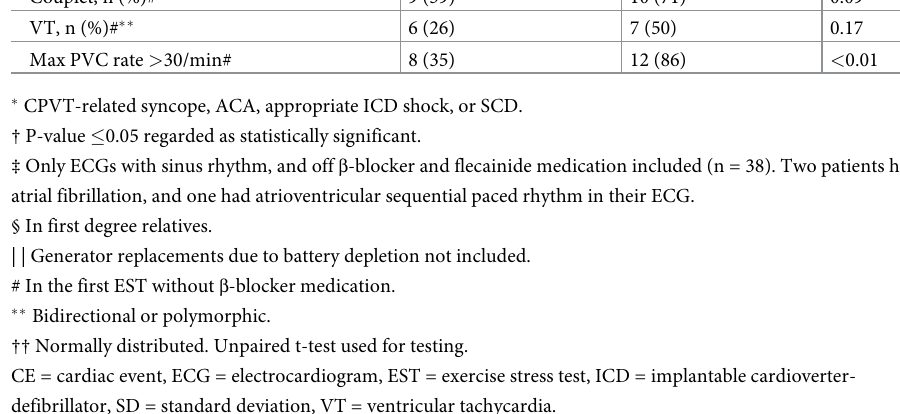
symptomatic. The cumulative rate of cardiac events was similar between females and males (45% vs 38%, respectively, p = 0.71), and regardless of whether the mutation had been inher- ited from mother or father (46% vs 42%, respectively, p = 0.54). Family history of cardiac events in first degree relatives associated with a higher rate of events (53% vs 0%, p = 0.04). The number of probands in the study was six, and they were all females. Probands were more often symptomatic compared to non-probands (83% vs 25%, p < 0.01). Of the probands two (33%) suffered an ACA, and one (25%) had an appropriate ICD shock therapy. ICD was implanted to four (67%) probands.